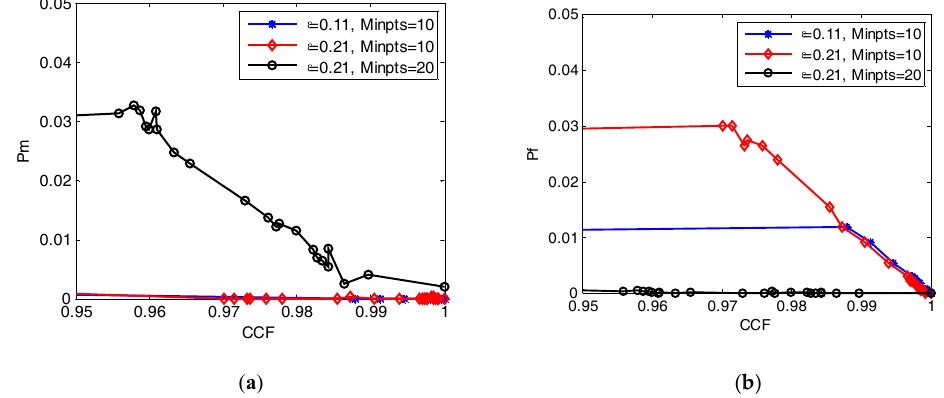
Figure 6. P m and P f predicted by HMM for NE GSM1800 DL band. ( a ) The relational graph between P predicted by HMM for NE GSM1800 DL band. ( a ) The relational graph P and Figure 6. f m P m and CCF with di ff erent ε and MinPts. ( b ) The relational graph between P f and CCF with di ff erent ε P and CCF with different ε and MinPts. ( b ) The relational graph between and between m with different ε and MinPts.